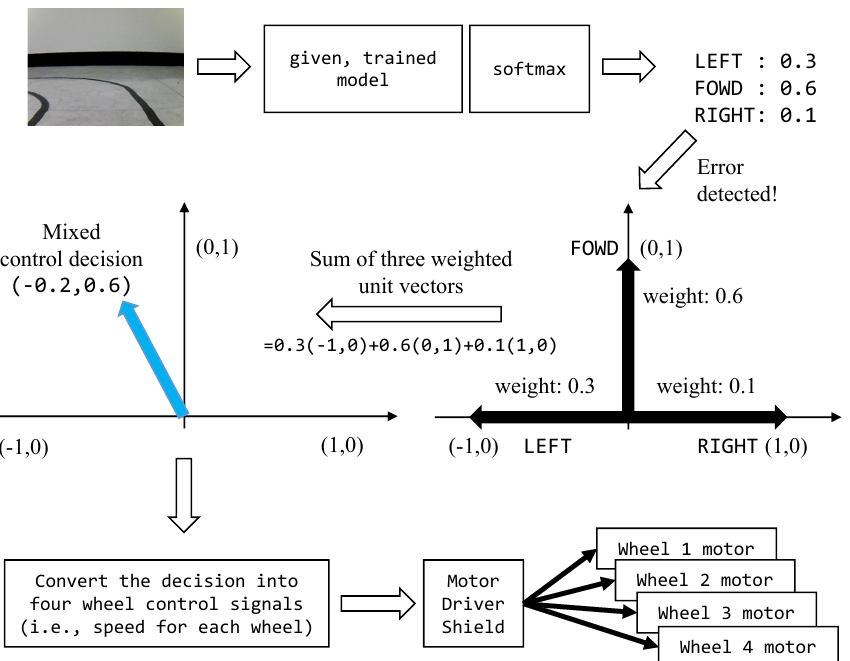
Figure 9. The way that UFrame makes a mixed control decision when the max2 uncertainty score exceeds the